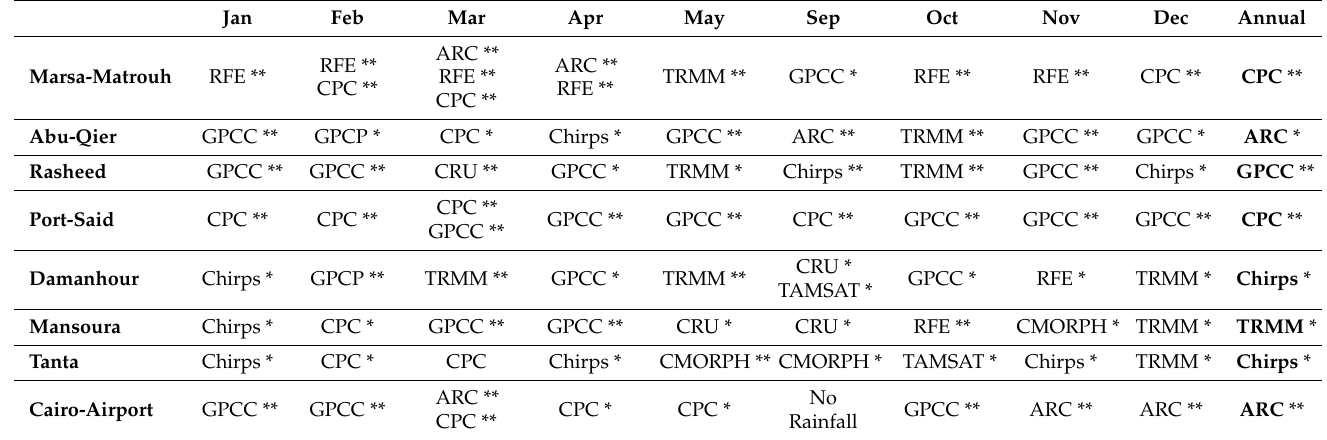
Table 4. Summary results of the best RP on monthly and annual timescales.